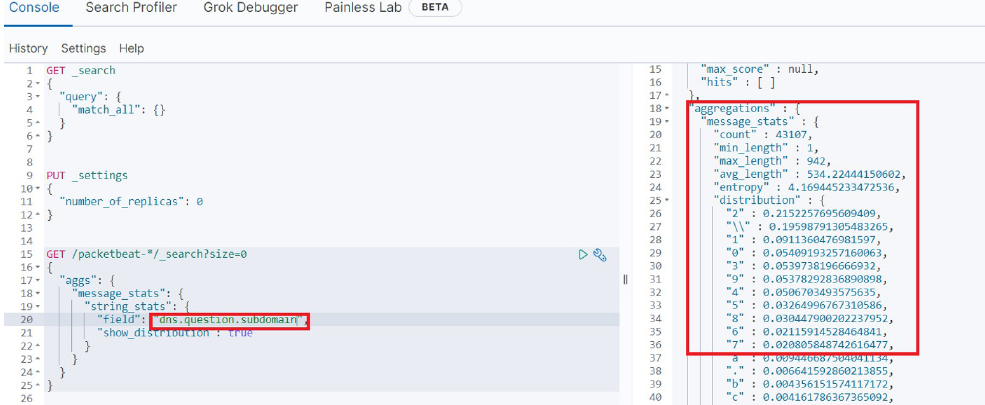
Figure 9. Character frequency probability visibility shown in the Kibana visualisation dashboard.